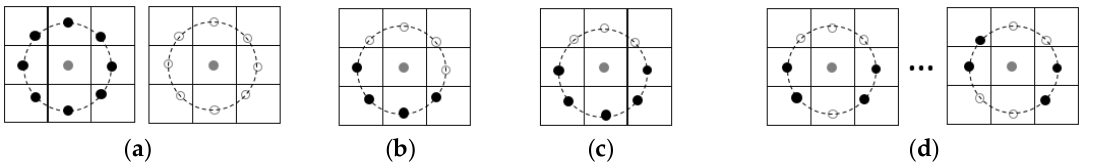
Figure 6. Example of LBP descriptors for representing micro-texture features: ( a ) flat/blob textures; ( b ) edge texture; ( c ) corner texture; and ( d ) complex noise-sensitive texture features.